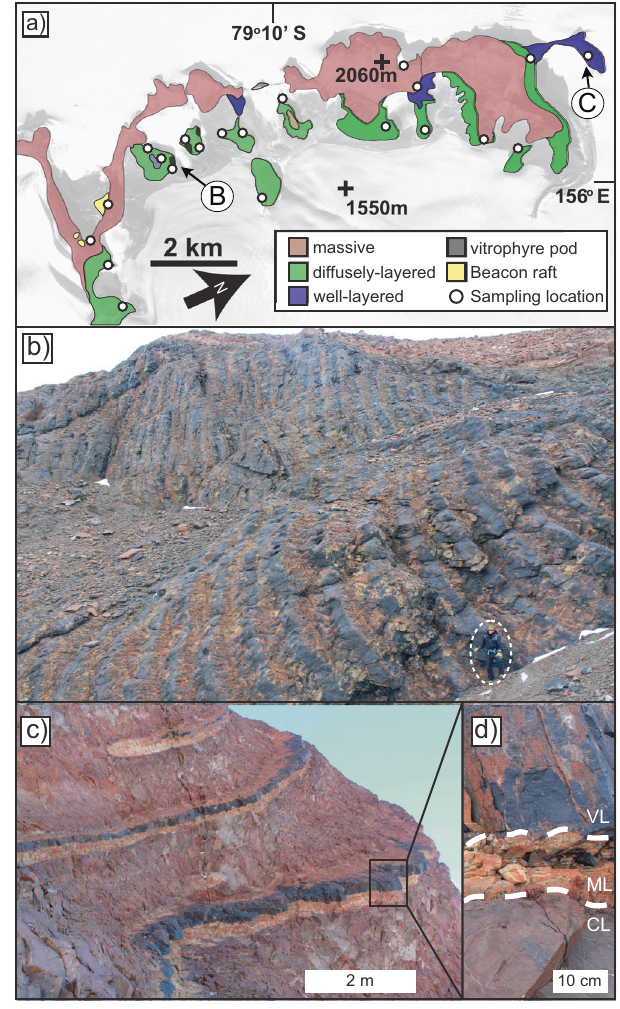
Fig. 2 | Geological features ofthe Butcher Ridge Igneous Complex. a Simpli fi ed geologic map of the Butcher Ridge Igneous Complex (BRIC) with locations of images ( b ) and ( c ) arrowed (overlain on WORLDVIEW-2 satellite map) Modi fi ed from Nelson et al. 5 . b Vitrophyrepod unitof theBRIC, person for scale lower right circled ( c ) well-layered rhyolite unit, and ( d ) close-up showing the distinct vitro- phyre (VL), marginal (ML), and crystalline (CL) layers. Images modi fi ed from: DemianA.Nelson,JohnM.Cottle,BlairSchoene;ButcherRidgeigneouscomplex:A glassy layered silicic magma distribution center in the Ferrar large igneous pro- vince, Antarctica.GSABulletin 132(5 – 6),1201 – 1216 (2020).https://doi.org/10.1130/ B35340.1.